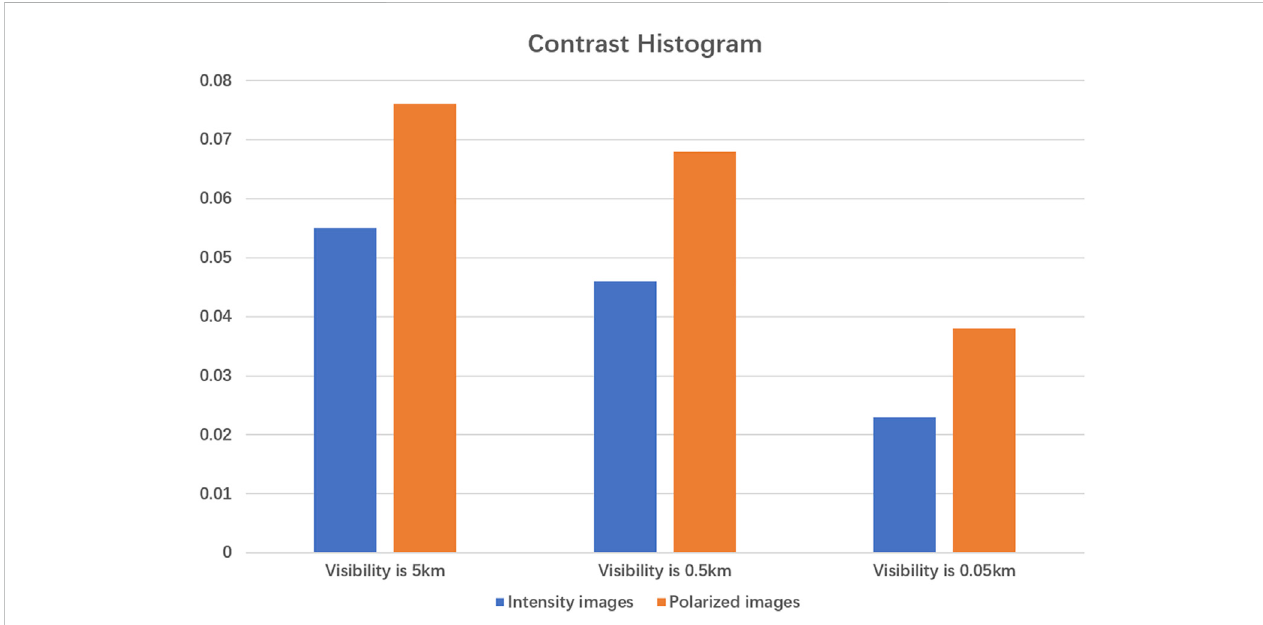
FIGURE 8 Histogram of contrast between intensity image and polarization image.